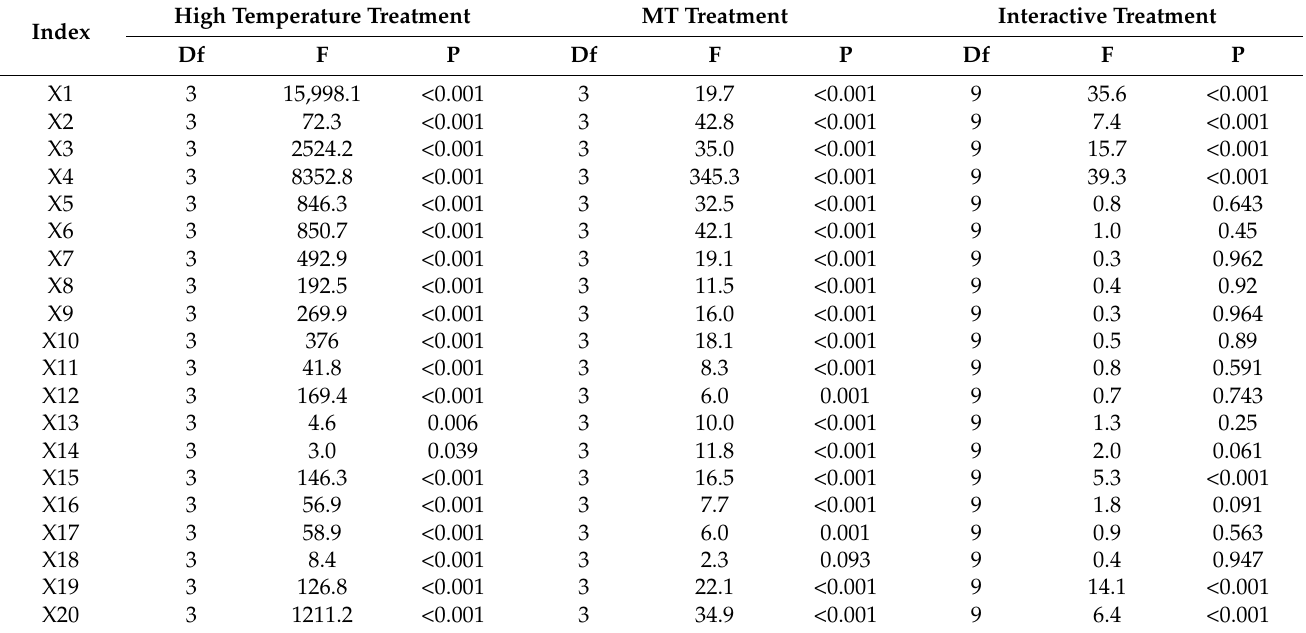
Table 1. Two-factor analysis of variance for the effects of high temperature stress and exogenous melatonin concentration on rice seed germination and physiological